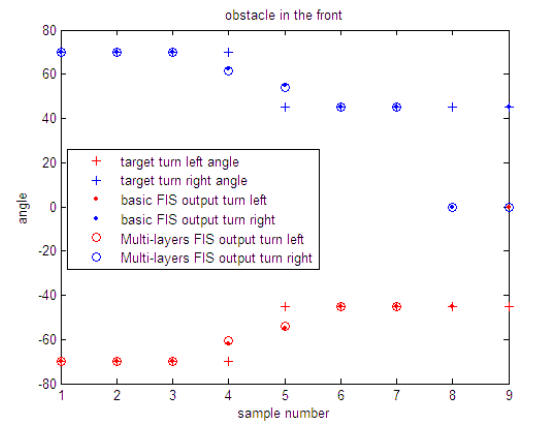
Fig. 15. Outputs of the multi-layer FIS and one layer FIS and target angles when the obstacle is in the front